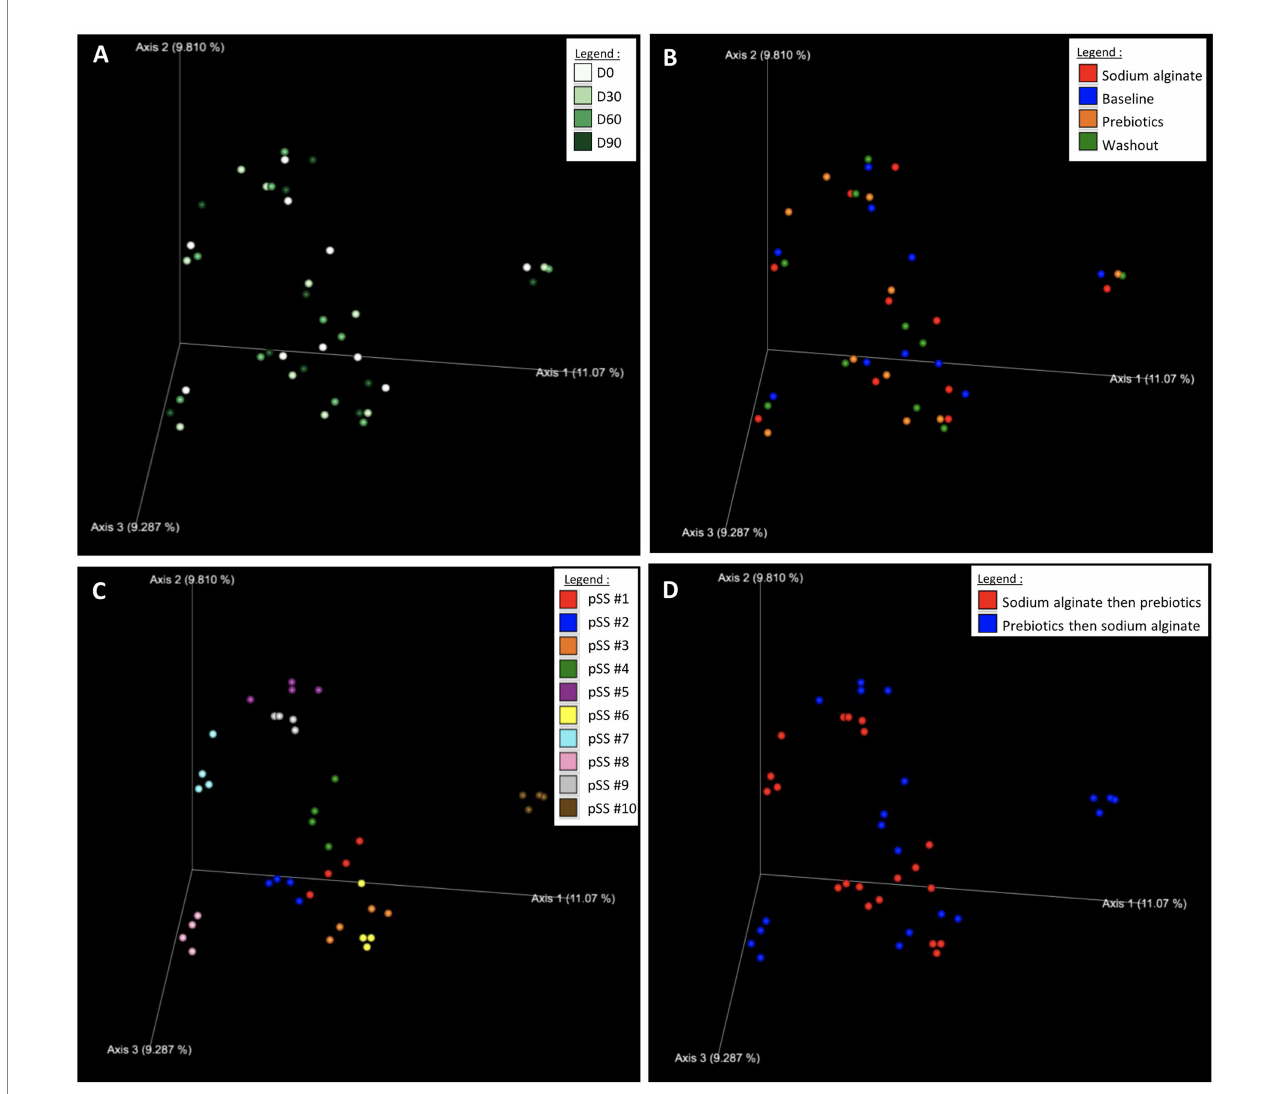
FIGURE 4 Beta diversity metrics Bray–Curtis Emperor plots for (A) study visits, (B) study phases, (C) participants, and (D) treatment sequence. The legend colors indicate the respective sample